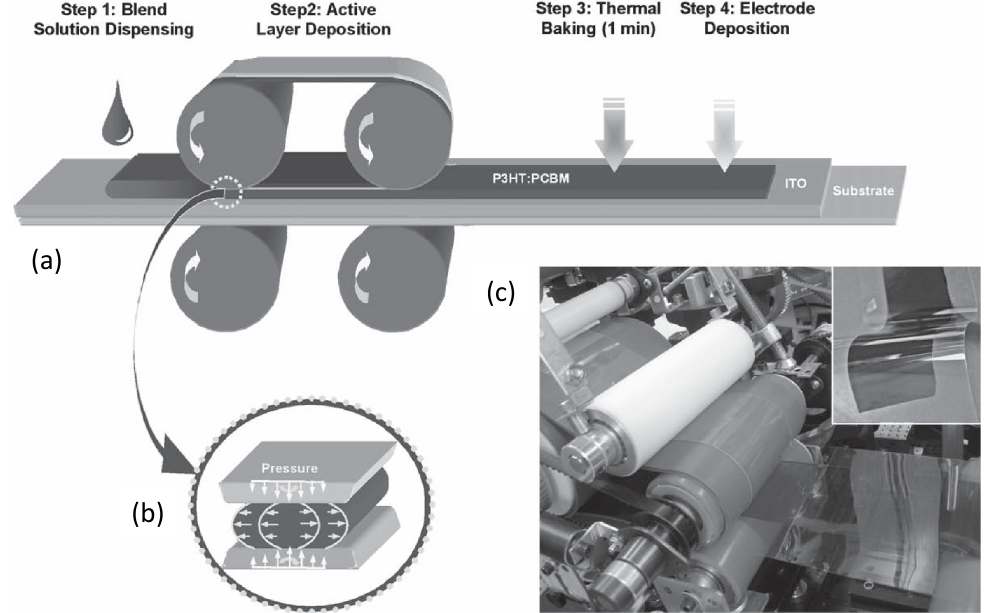
Figure 16. Schematic depiction of a roll-to-roll process for the large scale fabrication of OSCs: ( a ) casting of the D:A blend solution (ITO is indium tin oxide); ( b ) dynamic layer formation by controlled solvent evaporation, the sketch describes the solution shear flow inducing chain alignment; ( c ) A picture of the roll-to-roll apparatus (in the inset, the flexible OSCs before contact deposition). (Reprinted with permission from Reference [145]. Copyright (2010) by Wiley-VCH Verlag GmbH &